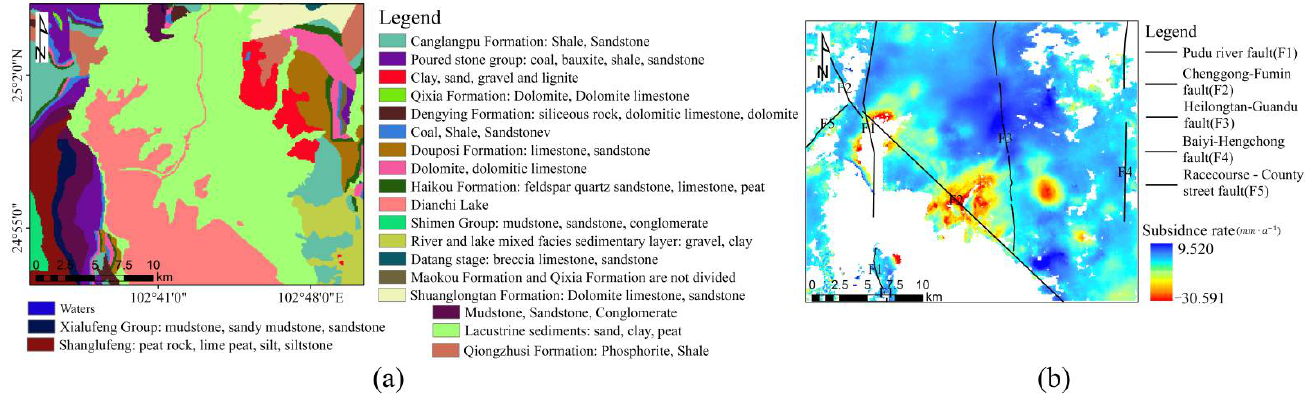
Figure 11. Geological structure and fault analysis of surface deformation: ( a ) is the geological structure data; ( b ) is the superimposed results of the fault and subsidence rate. Table 5. Physical and mechanical properties index of Quaternary lacustrine sedimentary layer soil.